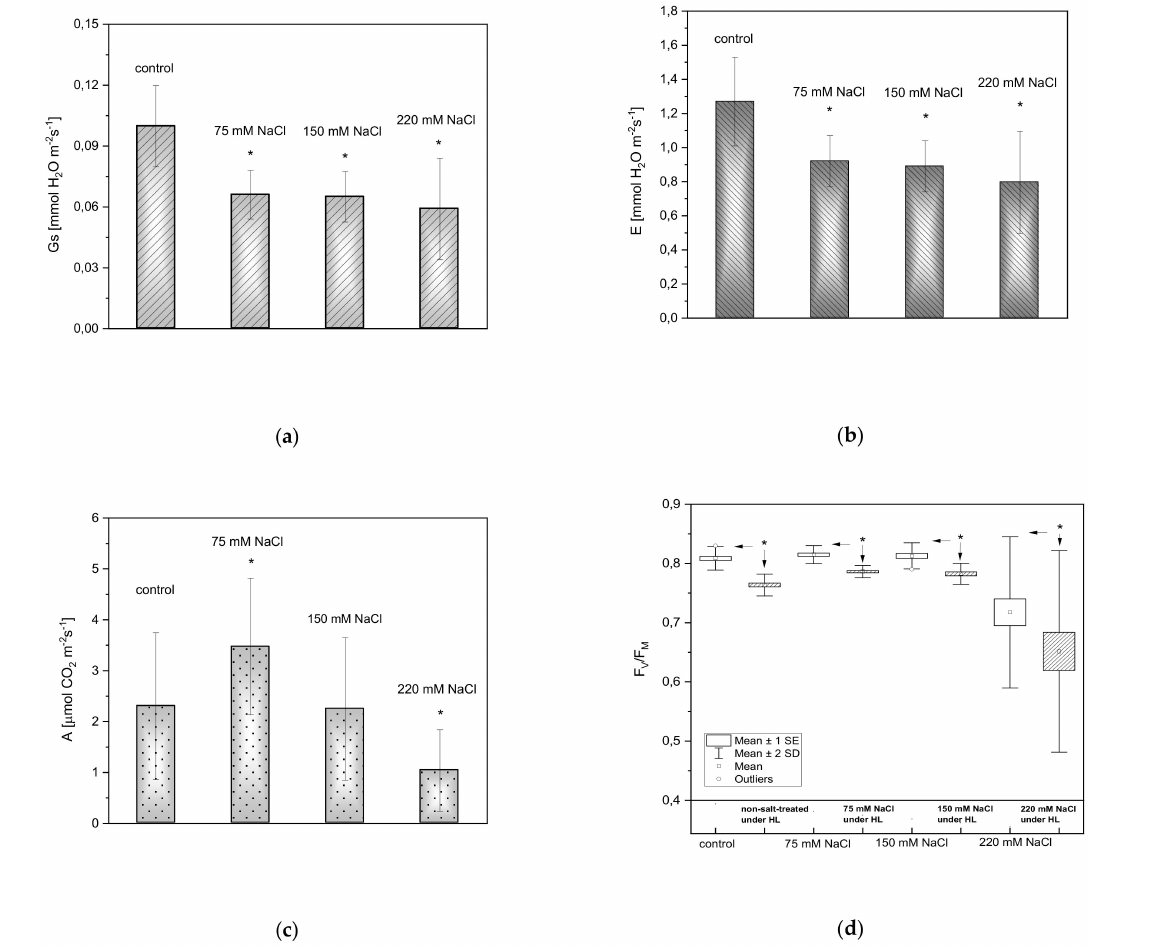
Figure 3. Stomatal conductance ( a ), transpiration rate ( b ), and the net CO 2 assimilation rate ( c ) measured three days after inducing salt stress in 4-week old A. thaliana rosettes. Maximal PSII efficiency (F V /F M ) in A. thaliana plants exposed to salinity under LL (empty box charts) and an acute HL (pattern-filled box charts) is shown in ( d ). Results are presented as box-and-whisker plots, showing mean, standard error, and outliers at the 95% confidence level. An asterisk (*) indicates significant differences ( p ≤ 0.05, the Mann-Whitney U test) between control and salt-treated plants ( a – c ), and plants before (LL) and after an acute HL treatment ( d